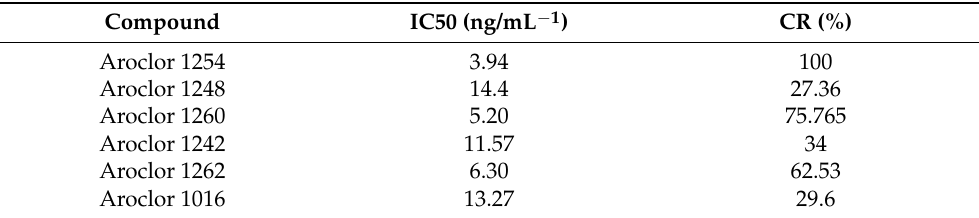
Table 4. The cross-reactivities of the antibody against Aroclor 1254 and other Aroclor using competi- tive